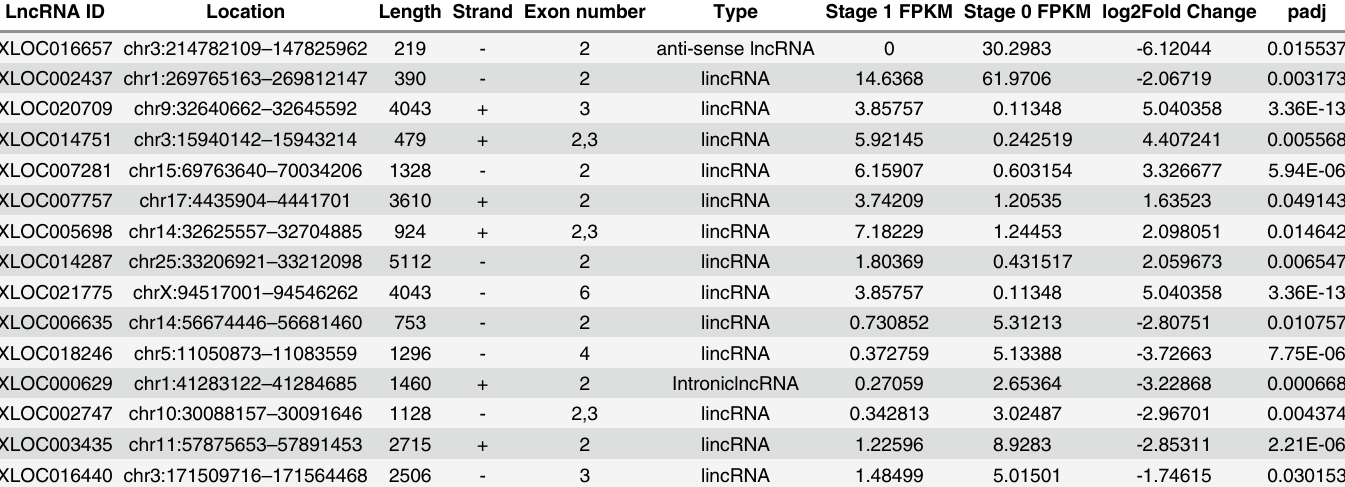
Table 2. Differentially expressed LncRNA in sheep skin between Stage 0 and Stage 1 group of secondary HF morphogenesis. LncRNA ID